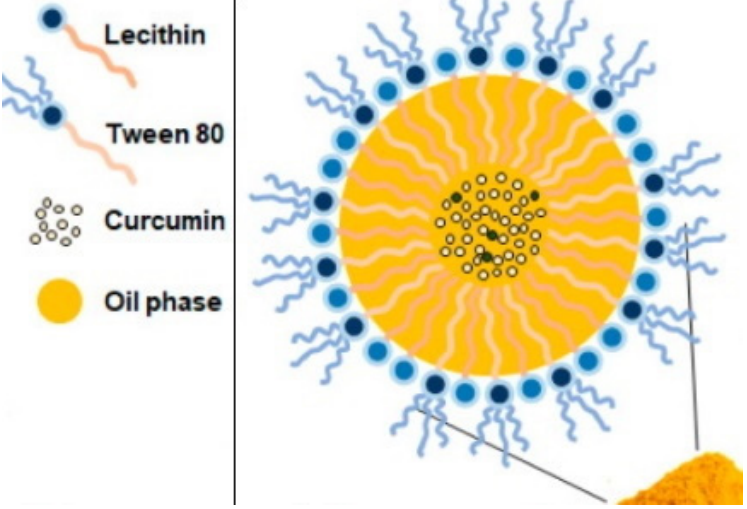
Figure 10. The structure of nanoemulsion droplet, consisting of lecithin as an emulsifier dissolved in oil phase, and Tween 80 as another emulsifier dissolved in aqueous phase, while the active material is curcumin. Adapted from reference [222].